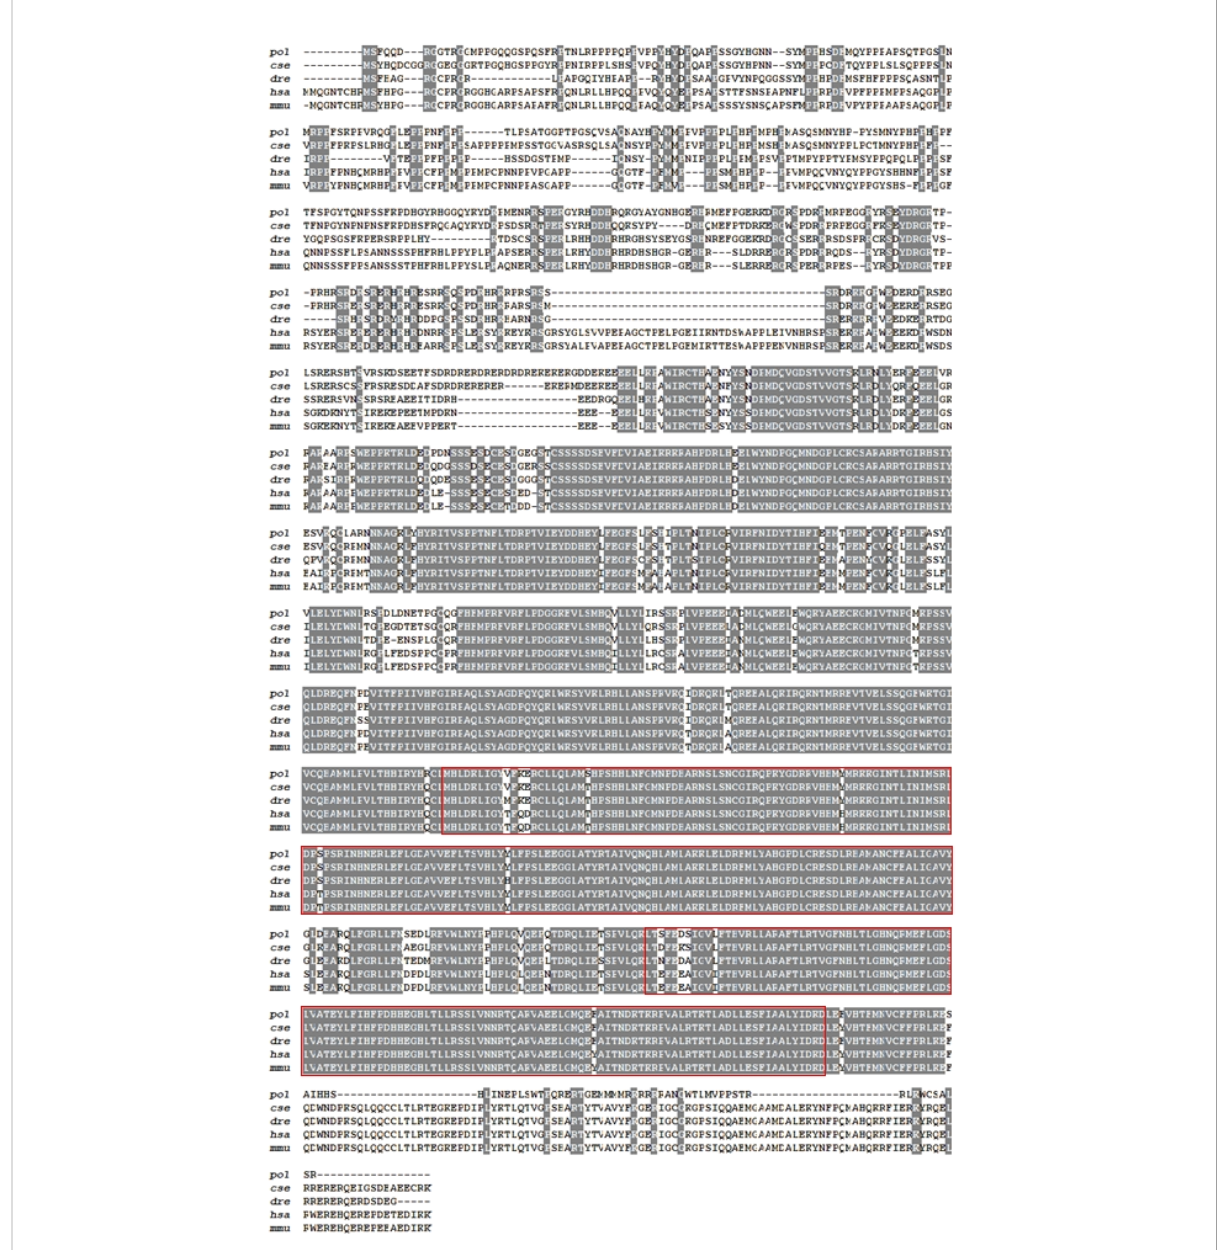
FIGURE 1 Amino acid sequence alignment of Japanese fl ounder Drosha with that of other species. Light gray blocks showed a few different residues between those sequences shown. The red box contains the active region of the RNase III superfamily. pol : Paralichthys olivaceus ; cse : Cynoglossus semilaevis (XP_008306545.1); dre : Danio rerio (NP_001103942.1); hsa : Homo sapiens (NP_037367.3); mmu : Mus musculus